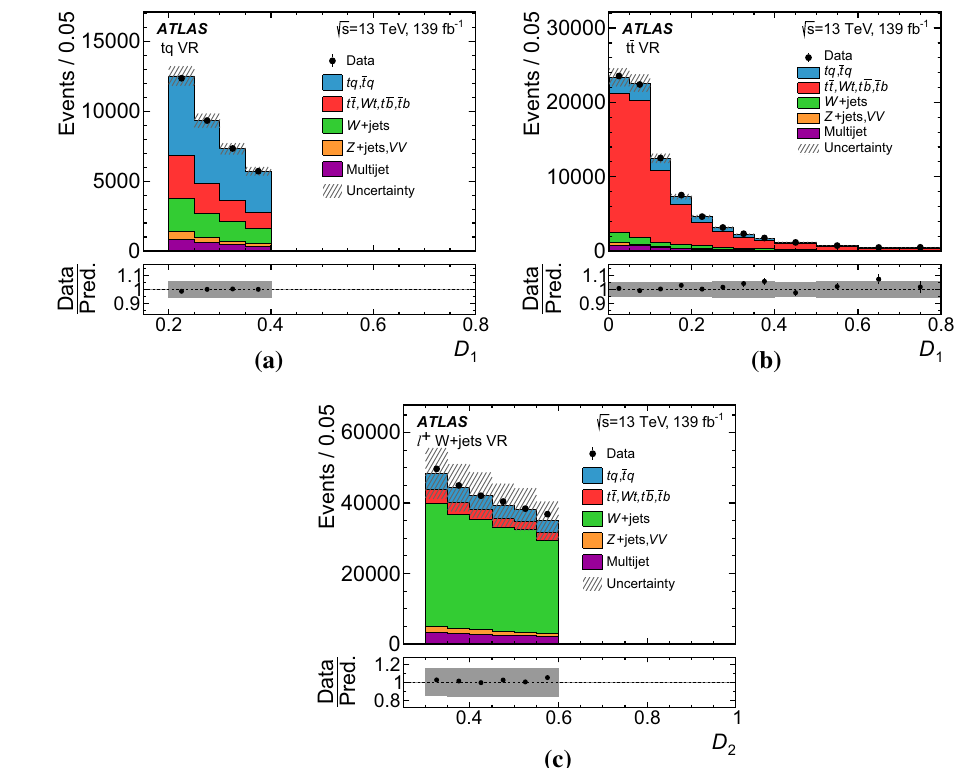
ugt analysis. The histograms in ( a ) show the distributions obtained in the cgt analysis, that is, the discriminant was evaluated for all selected events independent of sgn q ((cid:4)) . The distributions in the (cid:4) + channel of the ugt analysis are shown in ( b )